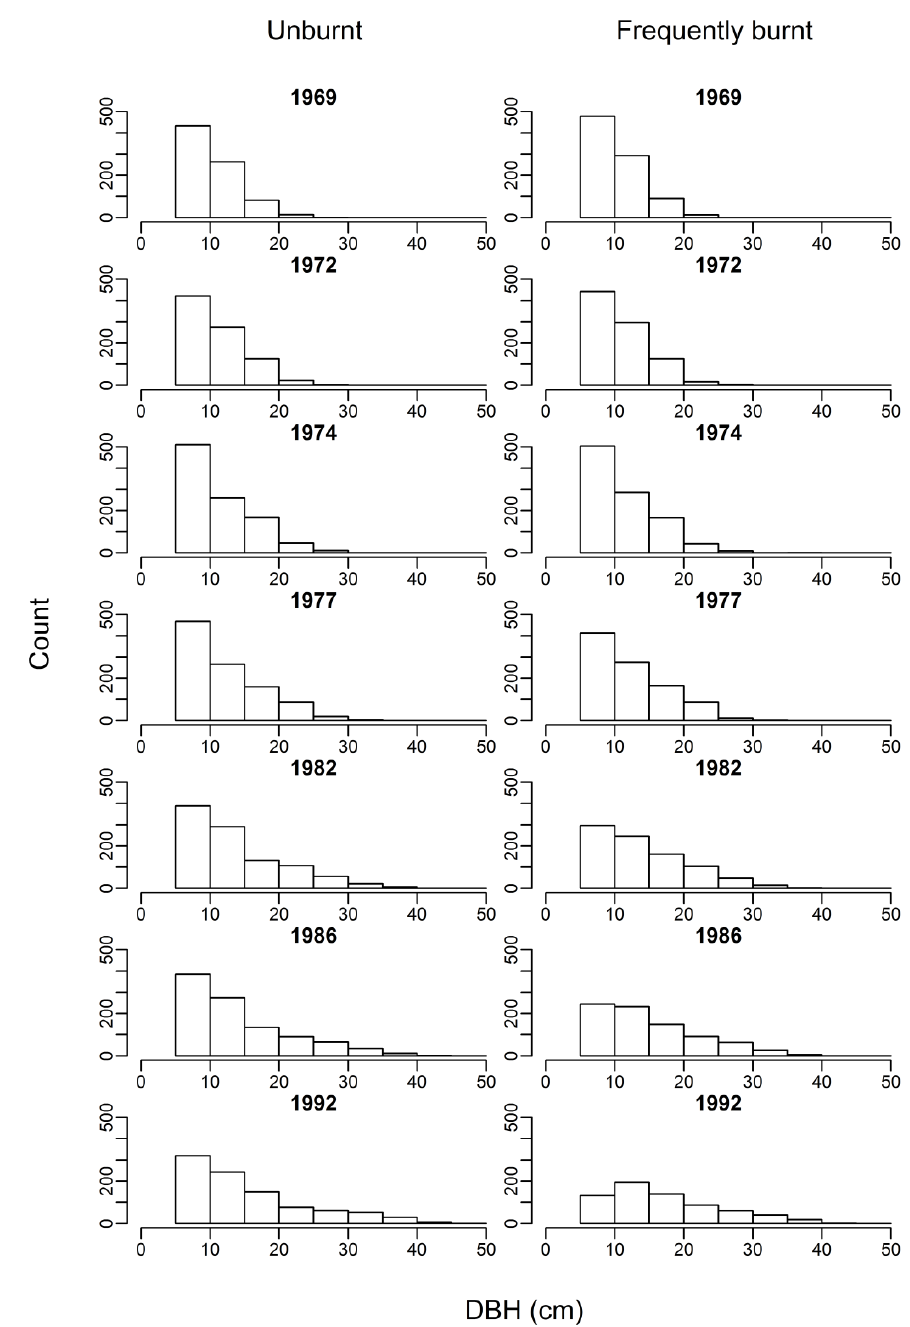
Figure 3. Histograms of diameter at breast height over bark (DBH) classes of overstorey species over time on frequently burnt and unburnt